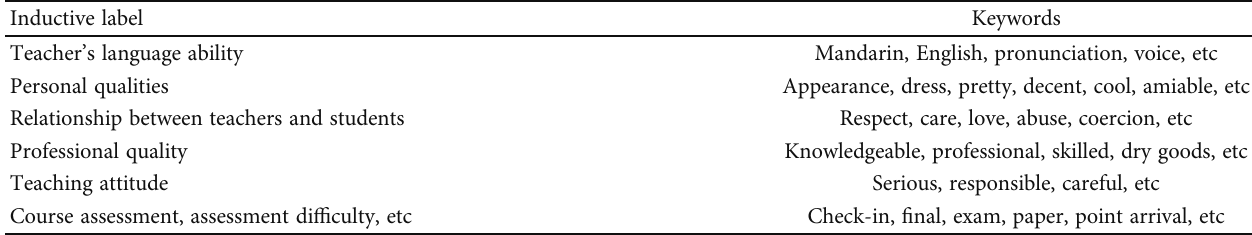
Table 4: Example of keyword induction section.